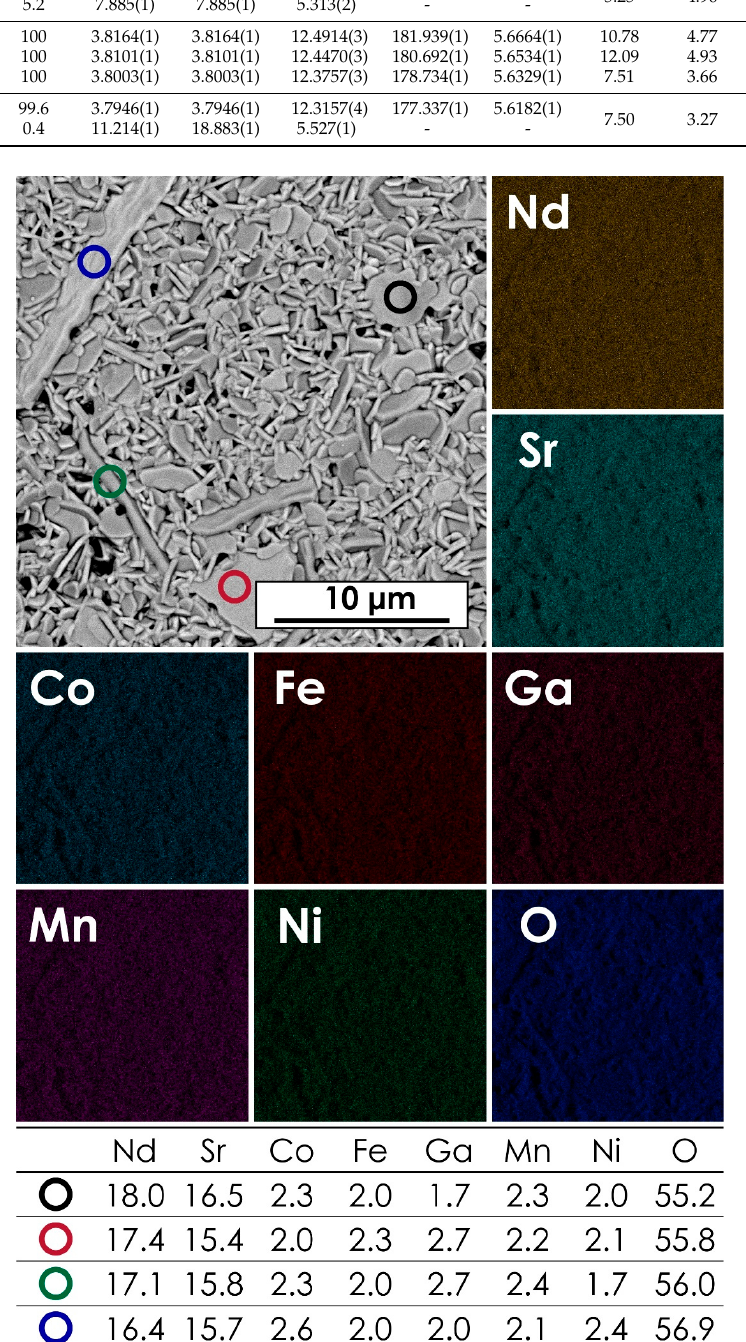
Table 1. The results of the Rietveld refinement analysis conducted for the LnSr(Co,Fe,Ga,Mn,Ni)O 4 (Ln = La, Pr, Nd, Sm, or Gd) materials, sintered at 1200 ◦ C for 20 h, together with the procedure’s residuals. The density of the pellets, as determined by the Archimedes method, is also provided. Space Group